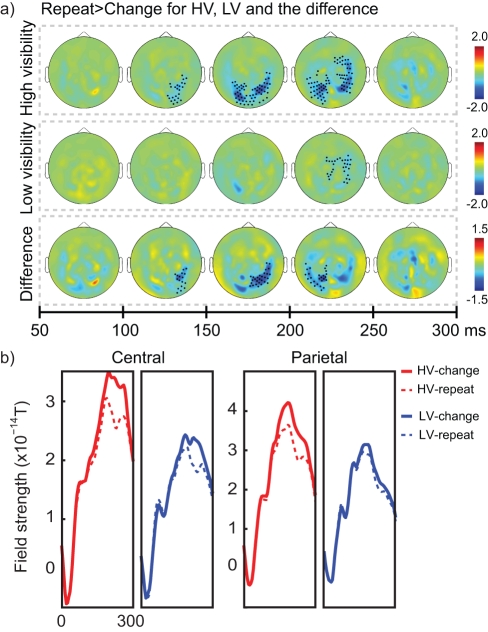
Neural markers of change in evidence.(A) Topographical representation of reduced activity for arrow stimuli that were preceded by an arrow with the same direction (“repeat”), compared to arrow stimuli which were preceded by an arrow with the opposite direction (“change”). Other conventions as in Figure 2. (B) Time course of central and parietal clusters. Central activity is plotted for the cluster that showed significant differences for both LV and HV arrows in the 200–250 ms interval. Parietal activity is plotted for the bilateral cluster that shows a significantly larger difference for HV than LV arrows in the 150–250 ms interval.